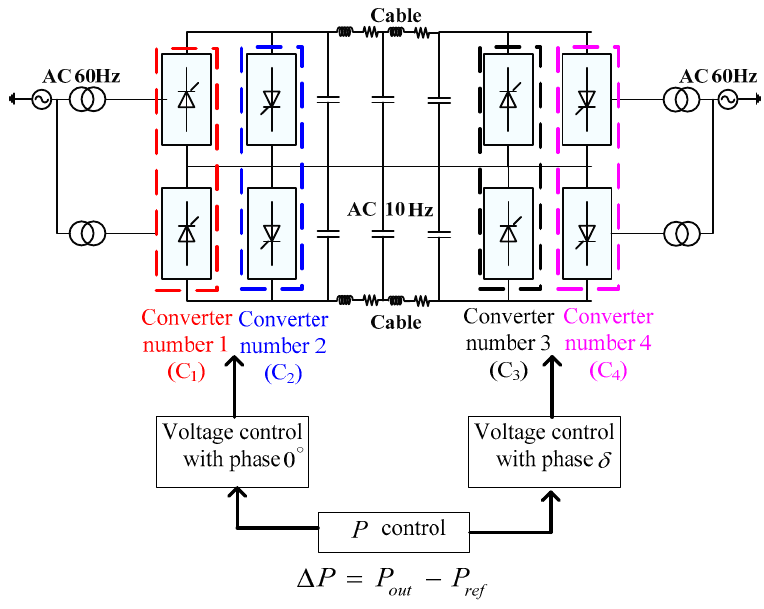
Figure 1. Concept of low frequency AC transmission system (LFAC) control scheme.